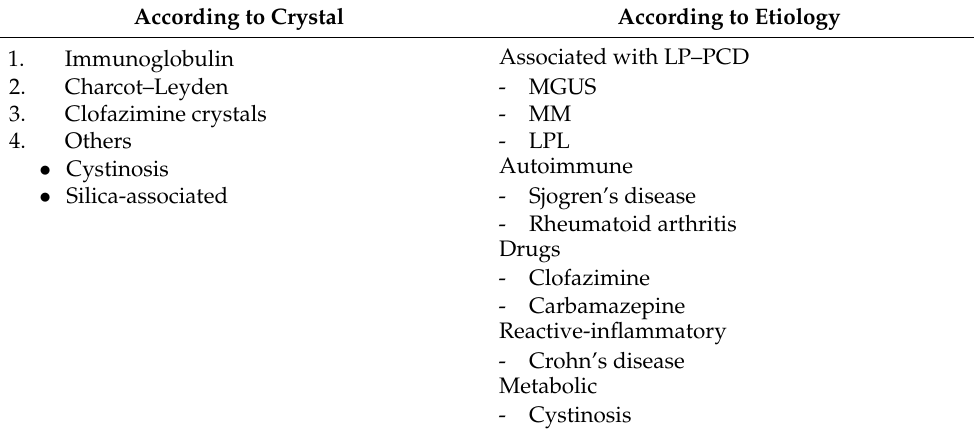
Table 4. CSH classification according to crystal and etiology.